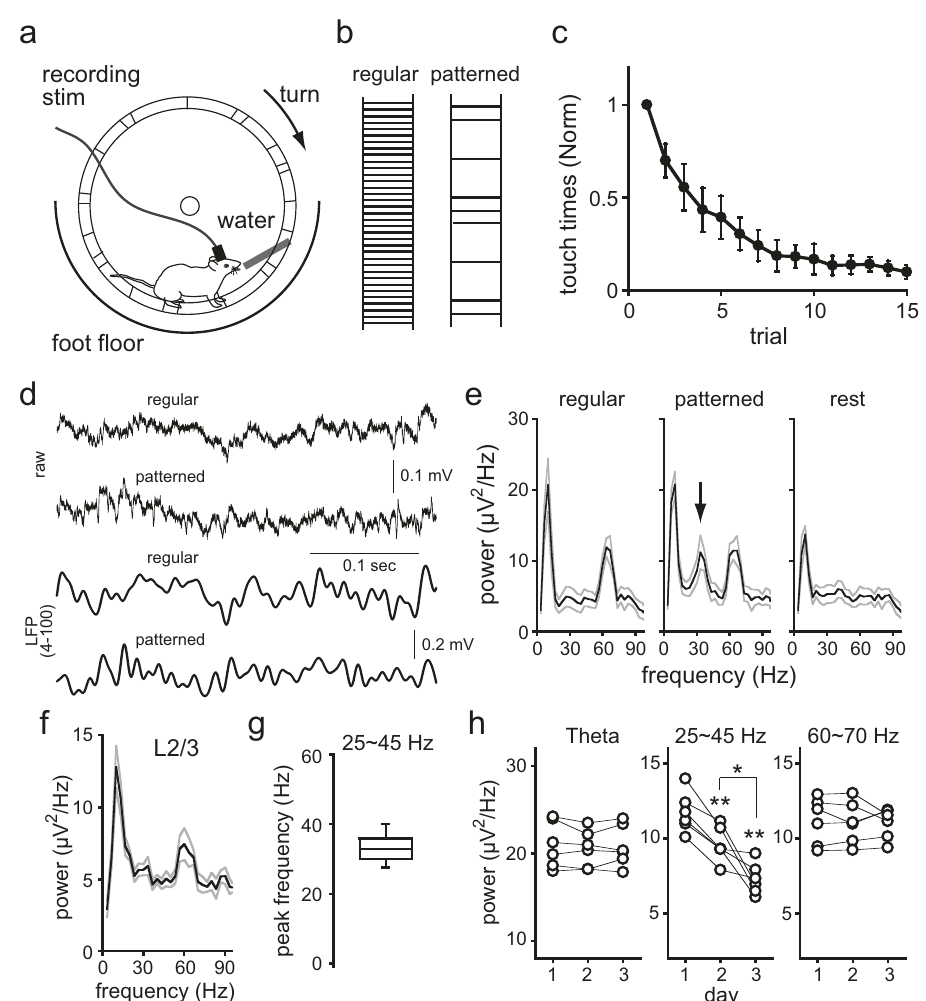
Fig. 6 Motor learning accompanied by LFP alterations. a Schematic drawing of the wheel running task. The wheel was driven by a motor at constant speed. Water supply port was inserted from the side of wheel. b Foot bar patterns used for habituation (regular task) and for learning (pattern learning task). c Learning progress monitored by reduction in the number of forelimb touches with the fl oor during the learning task from day 1 to day 3 (5 trials per day). Number of touches was normalized to that of the fi rst trial. Data are expressed as mean ± SD (n = 18 rats implanted optical cannulas). d Raw traces (upper) and LFPs (lower) during the regular task and pattern learning task (day 1). The LFPs were processed by a band-pass fi lter (4 – 100 Hz). e Power spectra of LFPs at rest ( n = 12), during the regular task ( n = 15), and during pattern learning task ( n = 18) obtained on day 1. The power increased around 30 – 40 Hz in the pattern learning task (arrow), but was not changed around theta and 60 – 70 Hz in both the regular and learning tasks. Power spectra were represented as mean ± SEM (black and gray line, respectively). f Power spectra of LFPs, represented as mean ± SEM (black and gray line, respectively), obtained at L2/3 during the learning task on day 1 ( n = 10). g Box plot of peak frequencies between 25 and 45 Hz in the LFP power spectra in L5 during the pattern learning task (day 1; n = 18). h Power at a peak frequency of theta, 25 – 45, and 60 – 70 Hz frequency band of LFPs obtained on days 1 – 3 of the learning task. Note signi fi cant decrease in power around 25 – 45 Hz through the trial days (paired t -test, day 1 vs day2, ** P = 0.00038, day2 vs day 3, * P = 0.0124, day 1 vs day 3, ** P = during pattern learning tasks (Fig. 6e). The peak frequency of the beta/gamma band in L5 was 32.9 ± 3.4 Hz (Fig. 6g, 18 rats), similar to that observed in PCs and FS cells in slice experiments (one-way ANOVA, F (2, 117) = 2.415, P = 0.0938; Bonferroni test, versus PCs, P = 0.0937, versus FS cells, P = 0.4821). The increase of beta/gamma frequency band was layer speci fi c. In LFPs obtained in L2/3 at day 1, beta/gamma-band activity was weak during tasks (Fig. 6f). In the current source density analysis (CSD), the current sink and source components were observed within L5 (Supplementary Fig. 5). These results suggest that beta/ gamma-band activity is generated in L5 local circuits.